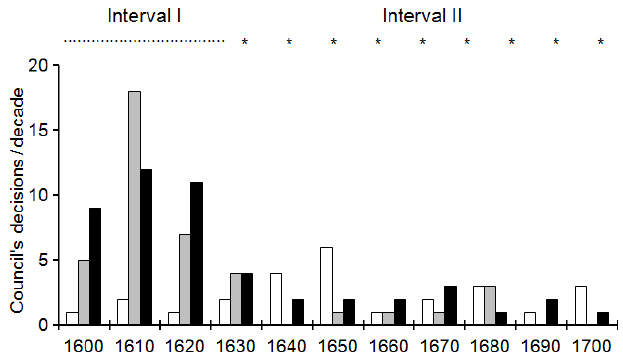
Fig. 2 . Responses to droughts displayed over decades, as reported by documentary sources. Open bars: decisions regarding symbolic responses; shaded bars: decisions regarding institutional responses; solid bars: decisions regarding infrastructural responses. See results section for a description of each